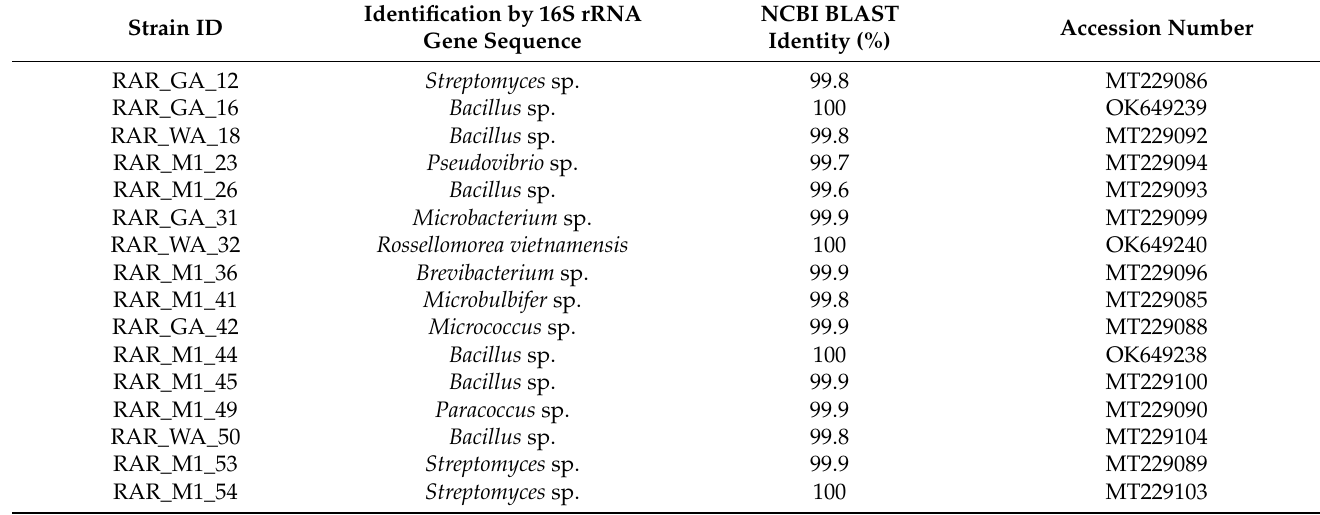
Table 1. Identification of the endophytic bacterial strains by 16S rRNA gene sequences. Identification by 16S rRNA NCBI BLAST Strain ID Accession Number Gene Sequence Identity (%) RAR_GA_12 Streptomyces sp. 99.8 MT229086 RAR_GA_16 Bacillus sp. 100 OK649239 Bacillus sp. 99.8 MT229092 Pseudovibrio sp. 99.7 MT229094 Bacillus sp. 99.6 MT229093 Microbacterium sp. 99.9 MT229099 Brevibacterium sp. MT229096 Microbulbifer sp. Micrococcus sp. MT229088 Bacillus sp. Bacillus sp. Paracoccus sp. Streptomyces